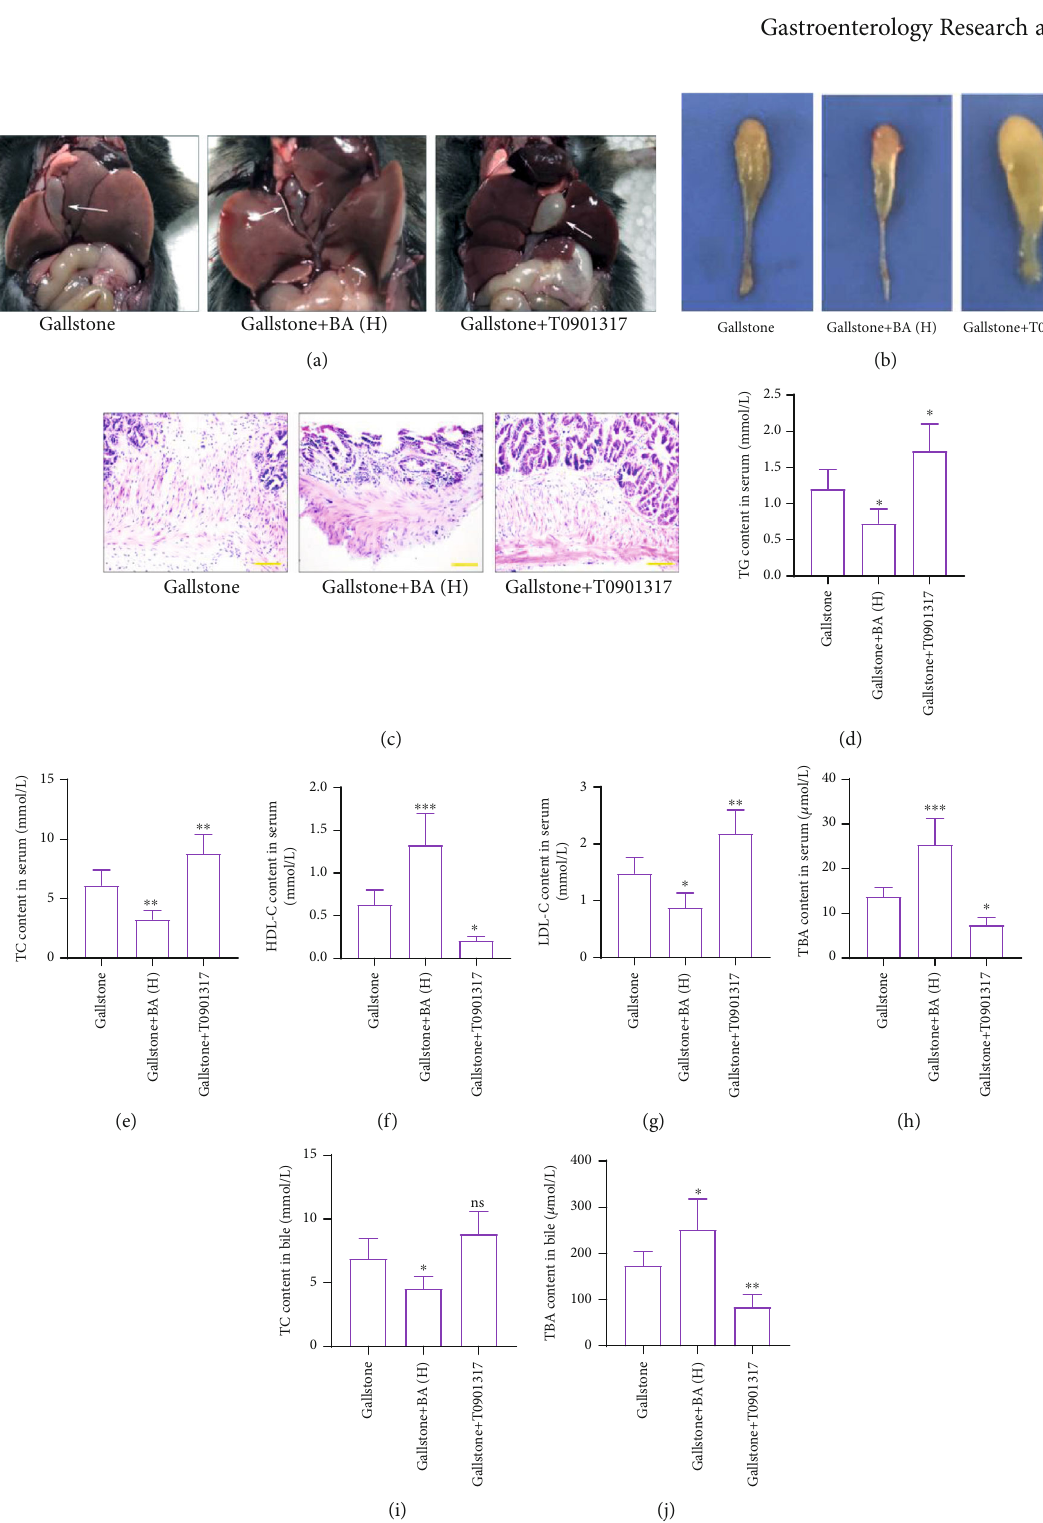
Figure 5: Baicalin restrained gallstone formation by inhibiting LXR α . (a, b) The representative pictures of gallbladders in mice with lithogenic diet and baicalin or LXR α agonist T0901317 (the arrows indicate the gallbladder). (c) HE staining was performed to detect the pathological and physiological characteristics of the gallbladders of mice in each group (the scale bar represented 100 μ m). (d – i) The content of TG (d), TC (e), HDL-C (f), LDL-C (g), and TBA (h) in serum. (i, j) The content of TC (i) and TBA (j) in bile. n = 6 ( ∗ p < 0 : 05 , ∗∗ p < 0 : 01 , and ∗∗∗ p < 0 : 001 ). ns: no signi fi cance; BA(H): 100mg/kg